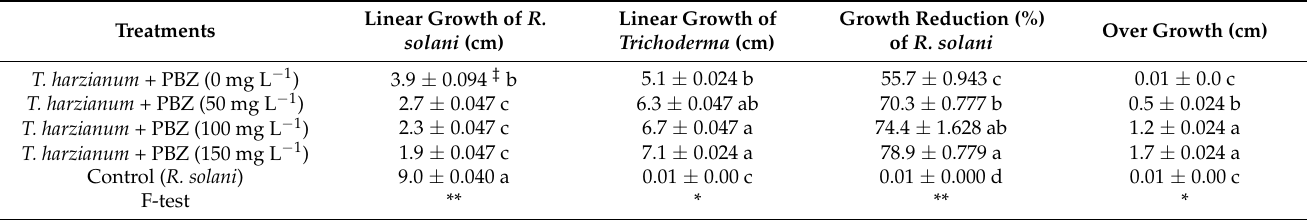
Table 5. In vitro antagonistic effect (inhibition) of Trichoderma harzianum against Rhizoctonia solani on PDA treated with PBZ applications.